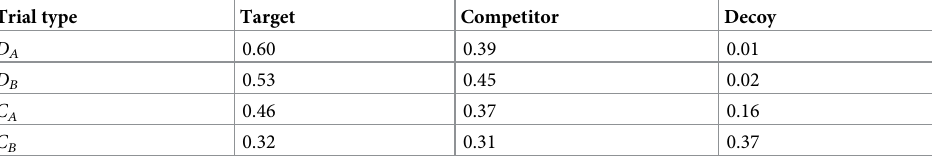
Table 1. Relative choice frequencies across participants in the four trial types. Across the group, target options were chosen more frequently than competitors in both types of attraction ( D A and D B ) and compromise trials ( C A , C B ). Dominated decoys were almost never chosen. In compromise trials including the high-outcome decoy C was chosen more frequently than core